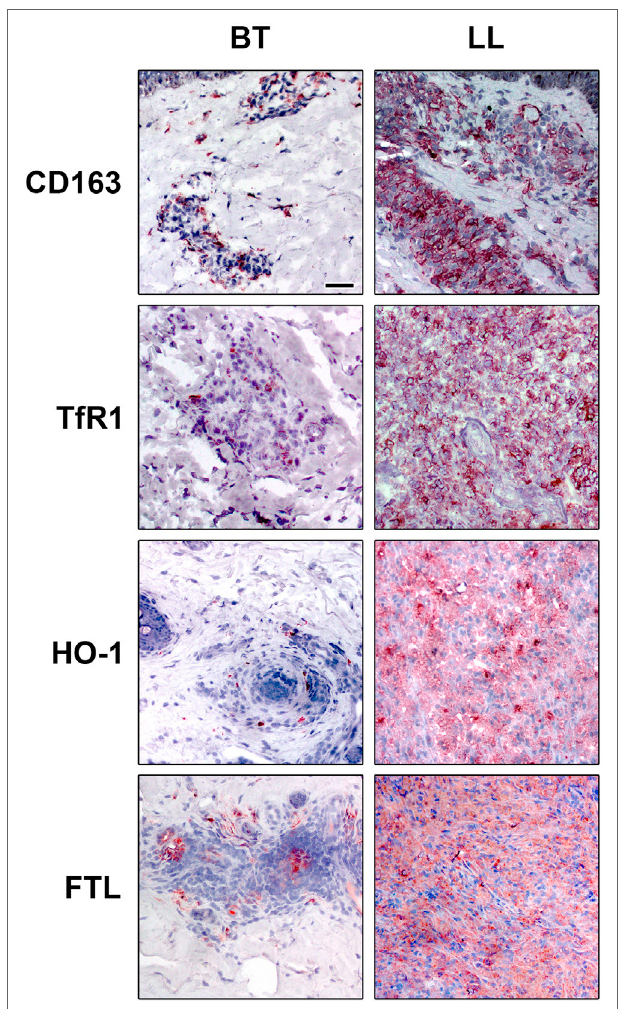
FiGURe 1 | Iron-related proteins are differentially regulated in leprosy clinical forms. Lepromatous skin lesions [lepromatous lepromatous (LL)] present a higher expression of the scavenger receptor of hemoglobin–haptoglobin complex, CD163 (upper panels), transferrin receptor 1 (TfR1, mid upper panels), the enzyme that catalyzes heme, heme-oxygenase 1 (HO-1, mid lower panels), and of the iron storage protein ferritin [ferritin light chain (FTL) lower panels]. The protein expression of CD163, TfR1, HO-1, and FTL was evaluated by immunohistochemistry. Images are representative of five independent samples from each group. Scale bars: 50